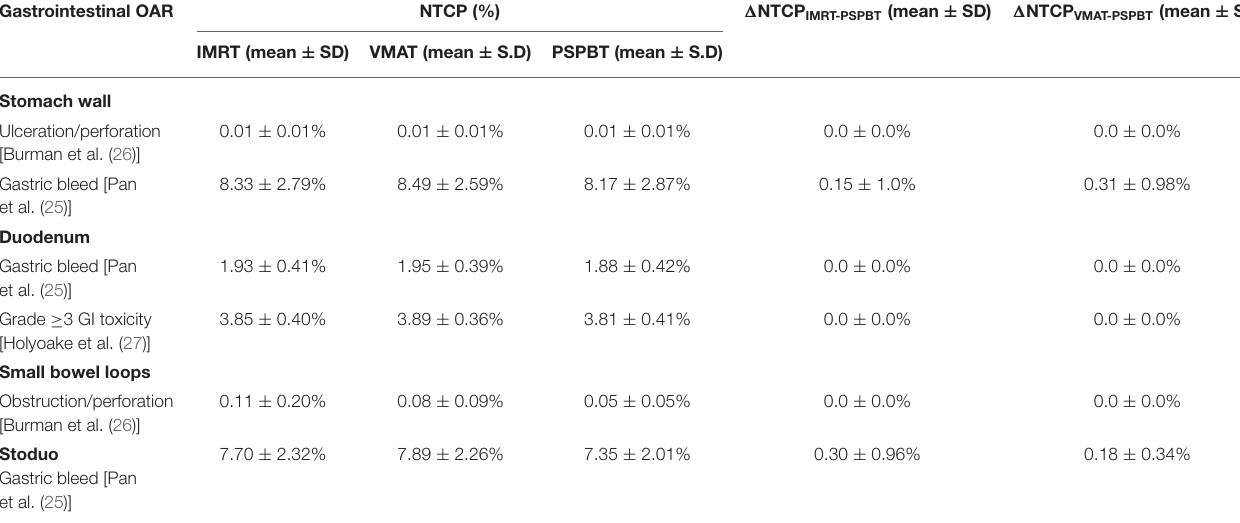
TABLE 4 | Normal tissue complication probability (NTCP) and NTCP reduction ( 1 NTCP) of gastrointestinal organ at risk (GI-OAR) radiation-related toxicity compared between the intensity-modulated radiotherapy (IMRT), volume-modulated arc therapy (VMAT), and 3D-passive scattering proton beam therapy (3D-PSPBT) plans. Gastrointestinal OAR